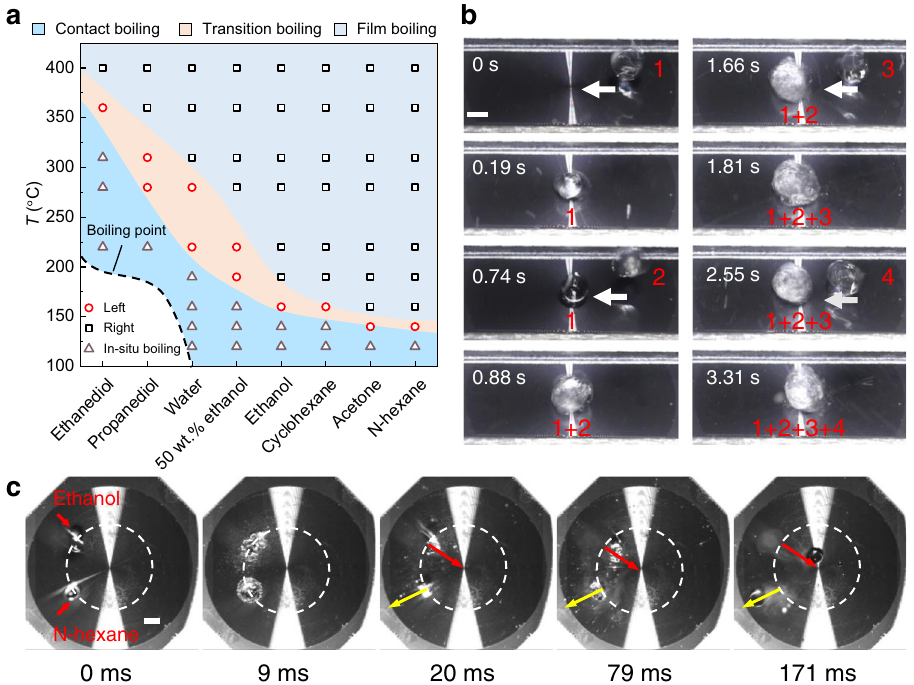
Fig. 5 Bidirectional transport of various liquids and drop sieving. a Phase diagram for different transport directions of various liquids at different temperatures. “ Left ” represents the drop rebounding towards the center of curvature, while “ Right ” represents the drop rebounding far away from the center of curvature. b Sequential images showing the convergence of successive water drops on the center of curvature at T = 250°C and We = 10.5. c Comparison between opposite rebounding directions of ethanol and n -hexane drops showing the ability of drop sieving at T = 160 °C, We = 10.5, and r = d /4. The ethanol drop bounces towards the center of curvature, while the n -hexane drop bounces far away from the center of curvature. Scale bars in b , c are 2